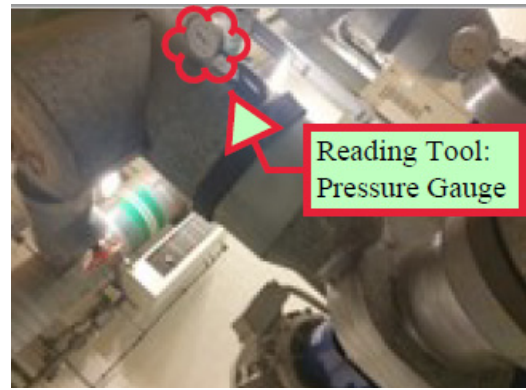
Figure 6. Pump Reading Tool.